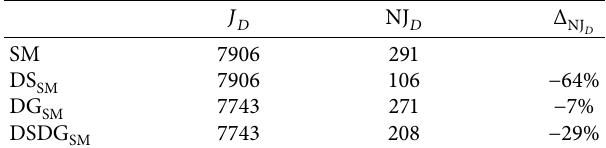
A LGORITHM 3: Dynamic gradient step estimation. Table 1: Efficiency of